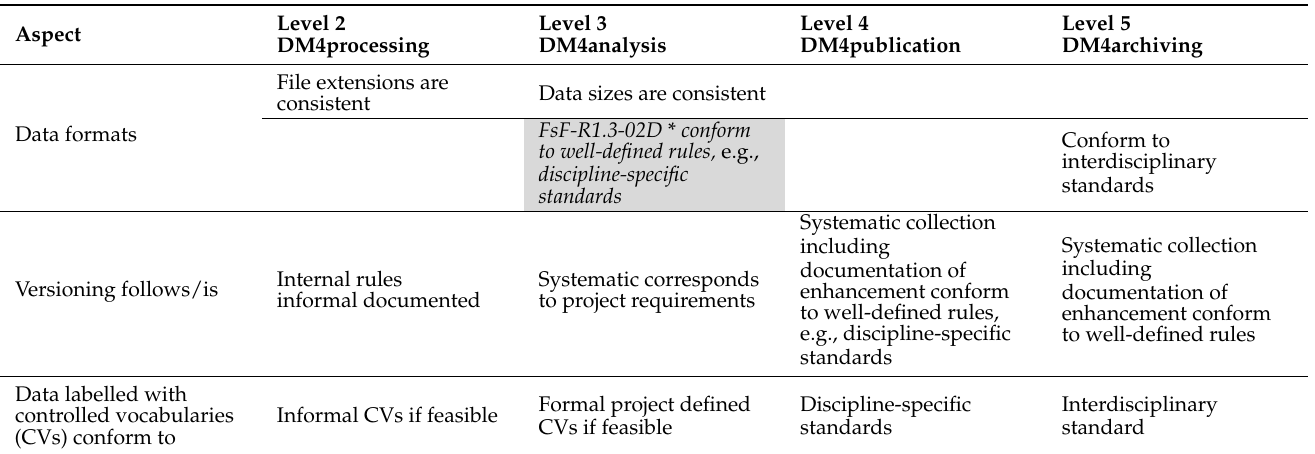
Table A1. Maturity matrix for the criterion technicality. Italic text marks changed or added metrics. Gray background marks level changes from original QMM. Removed measures from [34] are not listed in the